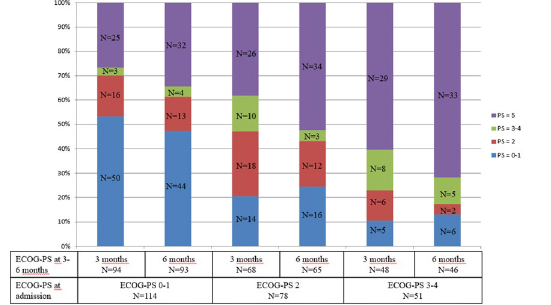
Fig. 1 ECOG‑PS at 3 and 6 months according to ECOG‑PS at ICU admis‑